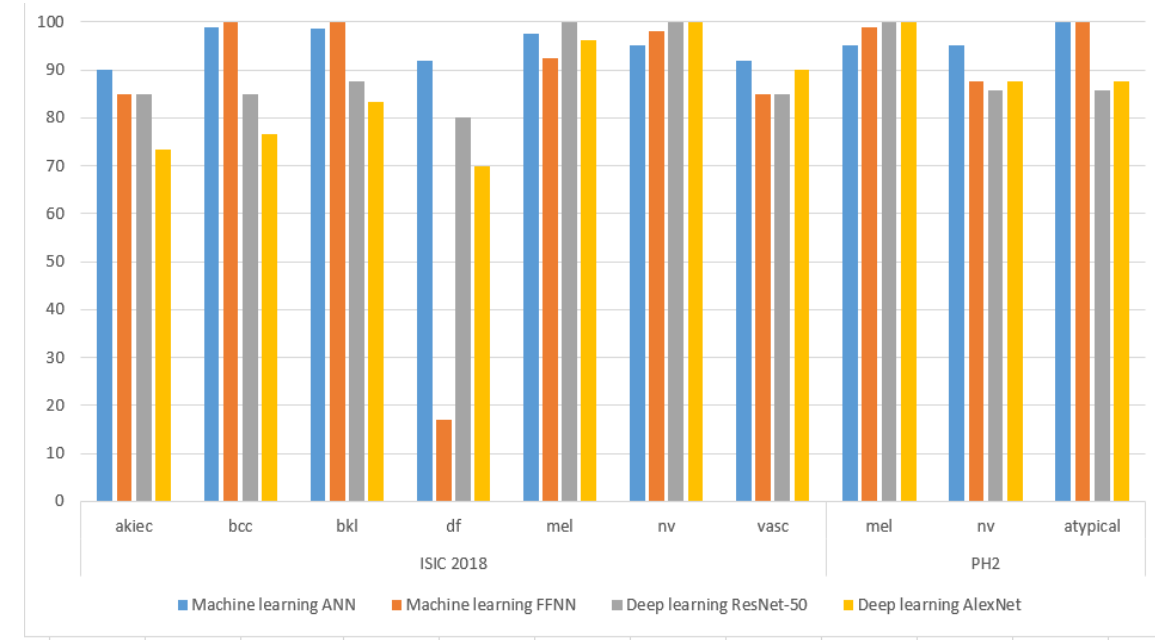
Figure 22. Performance comparison of the proposed systems for the early diagnosis of each skin disease analyzed in this study.